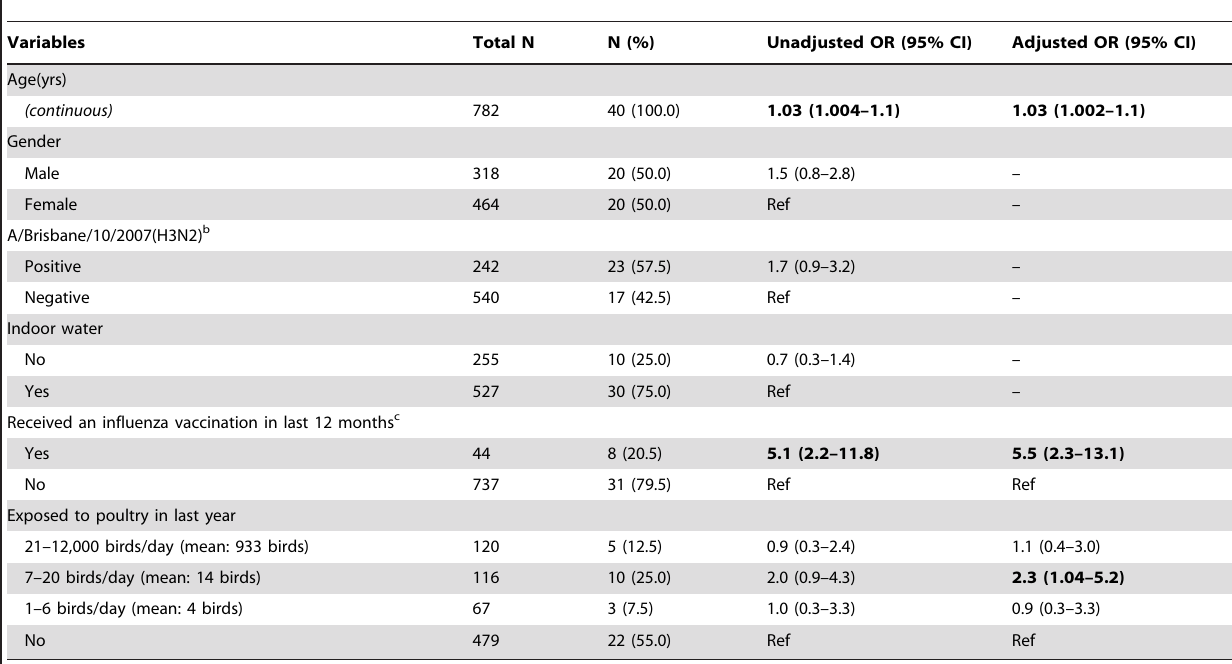
Table 2. Risk factors for elevated antibodies against A/Hong Kong/1073/1999(H9N2), among adult participants, Thailand, 2010 (24-month follow-up visit) using binary logistic regression a